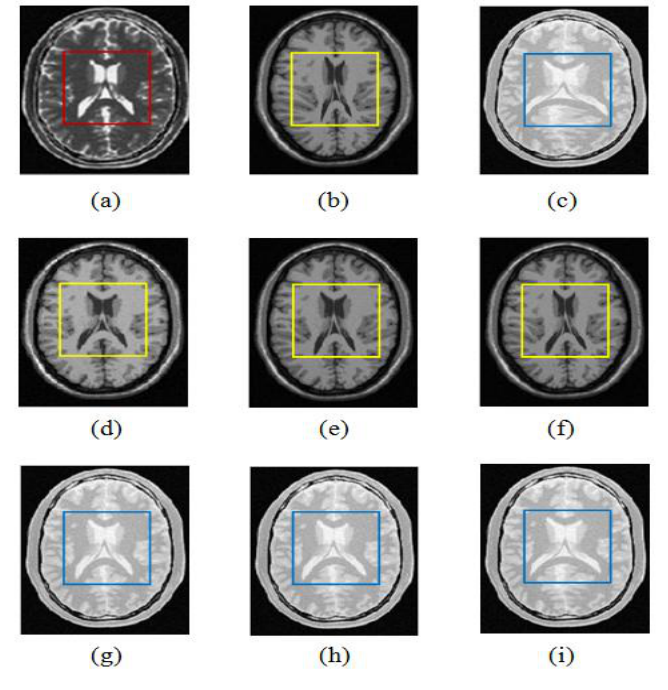
Figure 10. Non-rigid multi-modal registration results for the wldWSSIM-NMI, wldNSSD-NMI and ESSD-NMI methods operating on T1-T2 and PD-T2 weighted MR images. ( a ) T2 (the reference image); ( b ) T1 (the float image which is deformed by compressing mainly in the lateral ventricle marked with a yellow square.); ( c ) PD (the float image which is deformed by expanding mainly in the lateral ventricle marked with a blue square.); ( d ) wldWSSIM-NMI (T1-T2); ( e ) wldNSSD-NMI (T1-T2); ( f ) ESSD-NMI (T1-T2); ( g ) wldWSSIM-NMI (PD-T2); ( h )wldNSSD-NMI (PD-T2); ( i ) ESSD-NMI